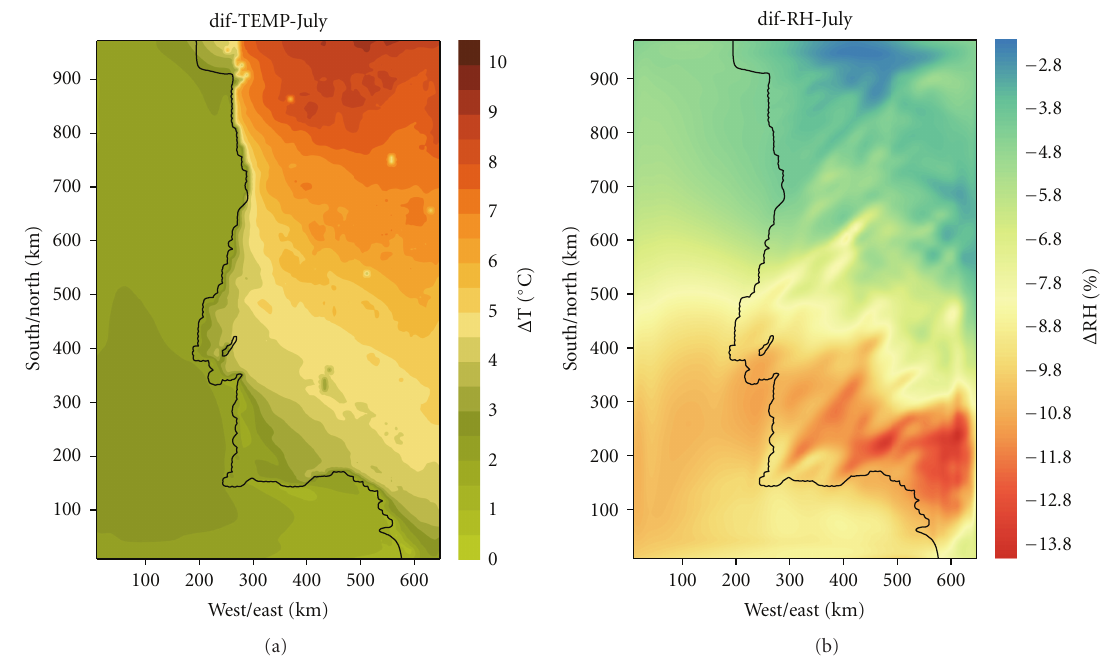
Figure 7: Temperature ( ◦ C) and relative humidity (%) di ff erences between future and reference climates simulated with the MM5 model across Portugal for